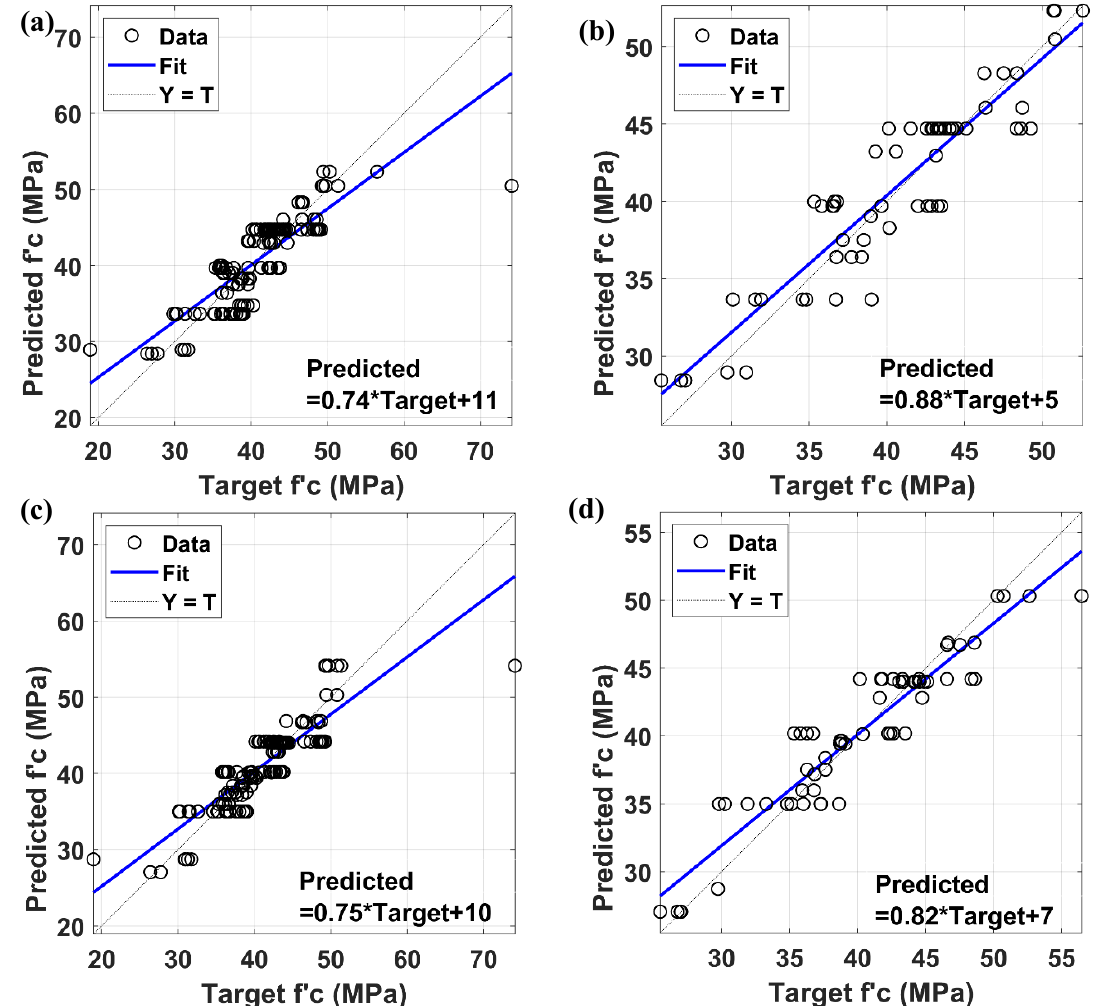
Figure 7. Correlation results analysis of ANN and ANFIS models: ( a ) training ANN, ( b ) testing ANN, ( c ) training ANFIS, and ( d ) testing ANFIS.